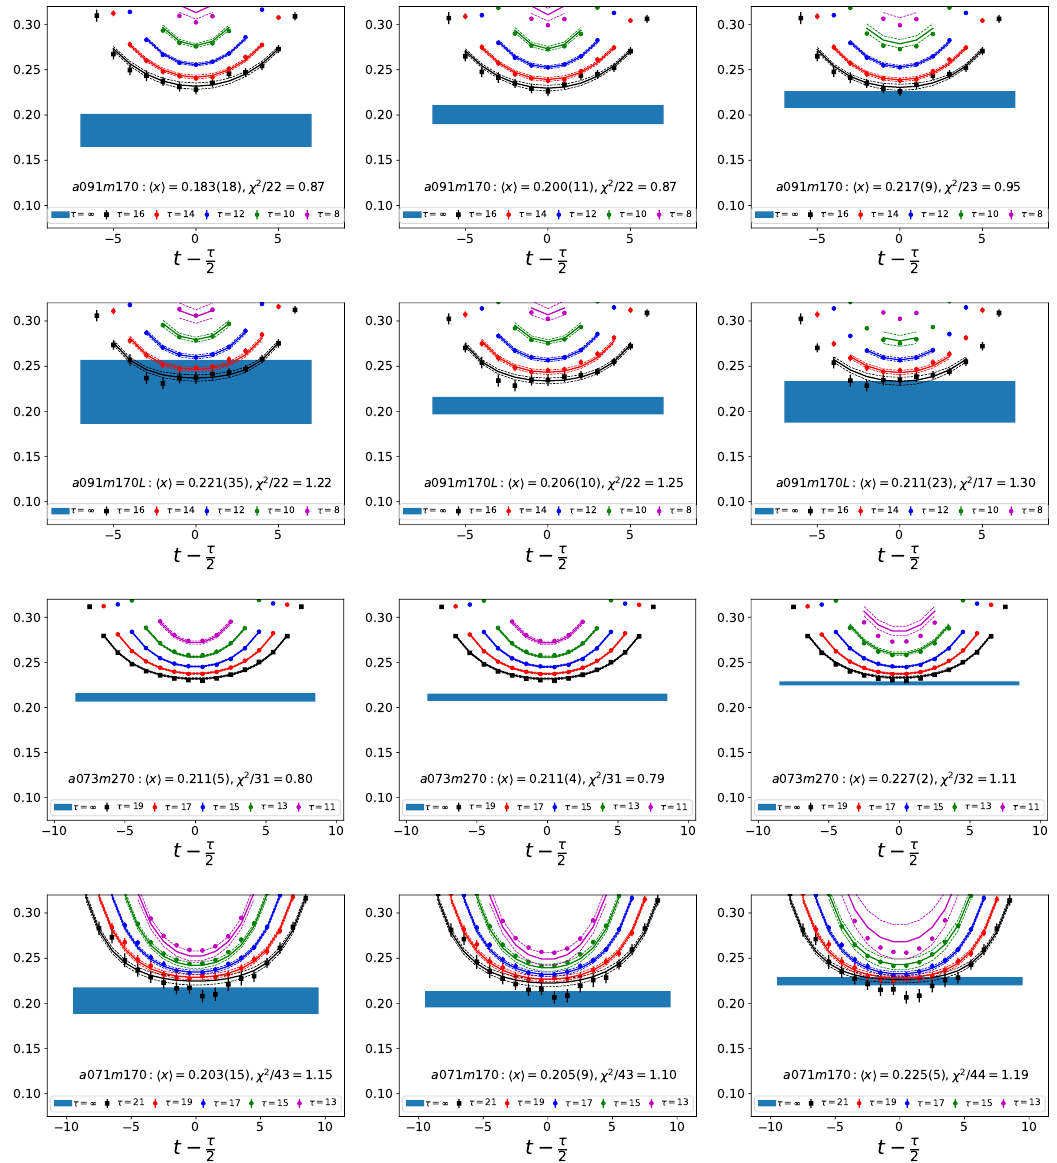
Figure 10 . Continuation of the data and fits to remove excited-state contamination in the ex- traction of the transversity moment h x i for a 091 m 170 (top row), a 091 m 170 L (second row), δu − δd ( τ ; t ) /C 2 pt ( τ ) is a 073 m 270 (third row), and a 071 m 170 (bottom row). The data for the ratio C 3 pt O scaled using eq. (3.10) to give h x i , and the fit parameters are listed in table 9. The rest is the δu − δd same as in figure